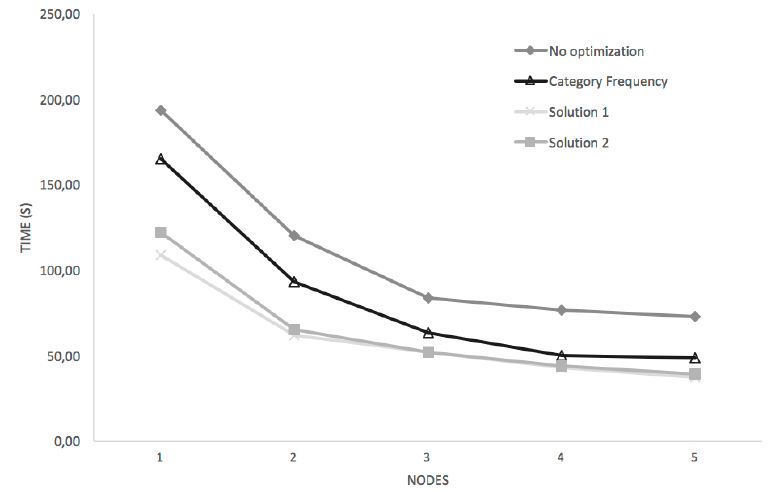
Figure 6. MEDLINE dataset, homogeneous environment.